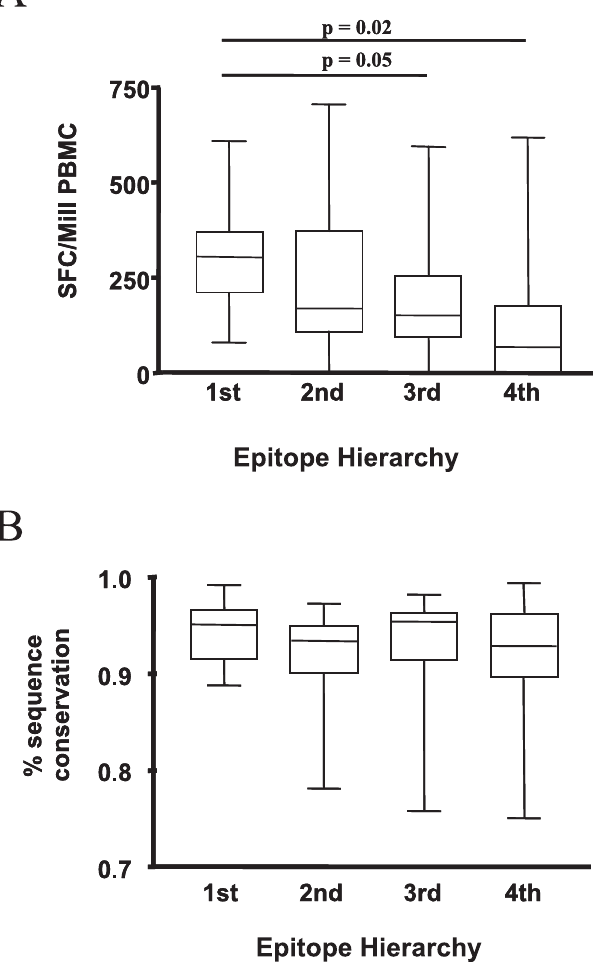
Figure 2. CD8 þ T Cell responses Directed against the Most Frequently Recognized CD8 þ T Cell Epitopes Were Also of the Highest Magnitude (A) For each HLA class I allele studied, the four most frequently targeted HIV-1-specific CD8 þ T cell epitopes were listed according to their hierarchy (for HLA class I alleles with only three described epitopes, the fourth value was excluded from the analysis). The average magnitudes of CD8 þ T cell responses directed against the 1st, 2nd, 3rd, and 4th most frequently targeted epitope for each allele were calculated (given as SFCs per million input PBMCs [SFC/Mill PBMC]) and are shown as box plots. The average magnitude of the most frequently targeted HIV-1- specific CD8 þ T cell epitopes restricted by each allele were significantly higher than the average magnitude of the 3rd and 4th most frequently targeted epitopes, and the respective p -values are provided above the box plot. (B) The sequence conservation within targeted CD8 þ T cell epitopes does not contribute significantly to the observed immunodominance patterns of HIV-1-specific CD8 þ T cell response in primary infection. For each HLA class I alleles studied, the four most frequently targeted HIV-1-specific CD8 þ T cell epitopes were listed according to their hierarchy (for HLA class I alleles with only three described epitopes; the fourth value was excluded from the analysis). The average sequence conservations, in comparison to HIV-1 clade B sequences published in the Los Alamos Database, of the 1st, 2nd, 3rd, and 4th most frequently targeted epitope for each allele were calculated (given as percent sequence conservation) and are shown as box plots. The average percentage of sequence conservation of the four most frequently targeted HIV-1-specific CD8 þ T cell epitopes restricted by each allele did not differ significantly. DOI: